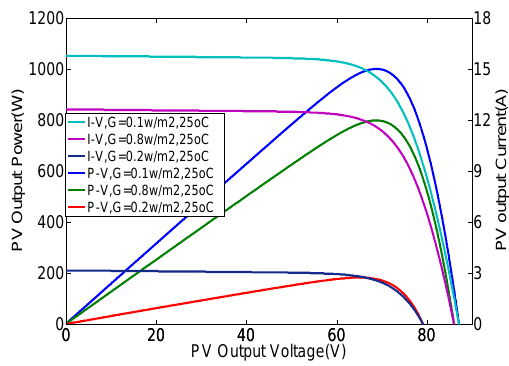
Figure 2. PV cell characteristics curves under different solar insolation.